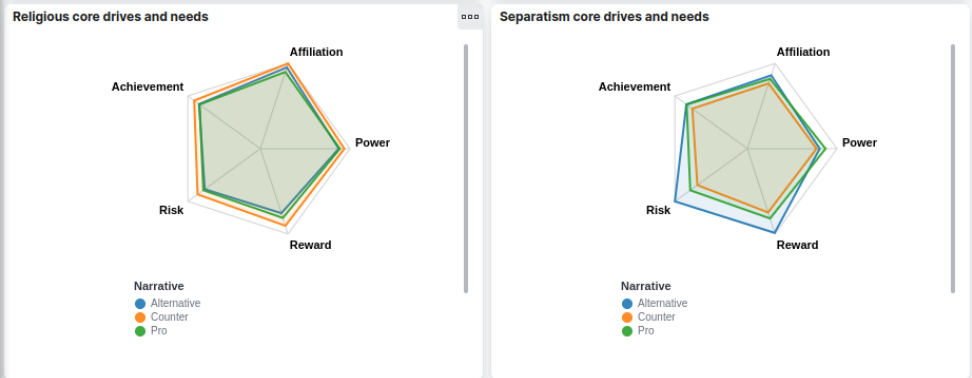
Figure 10. Overview of the interface. Part III. Spider charts.